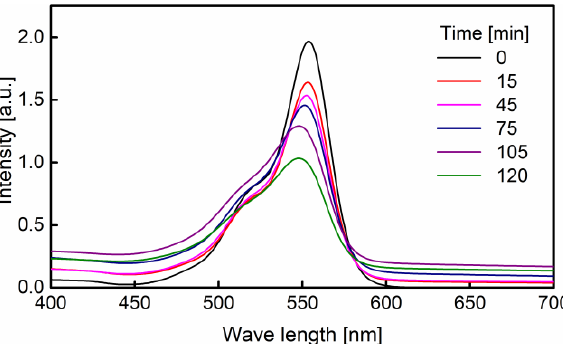
Figure 15. Absorption spectra of Rh-B dye in the existence of the Fe/Ti = 10% sample at various irradiation times.